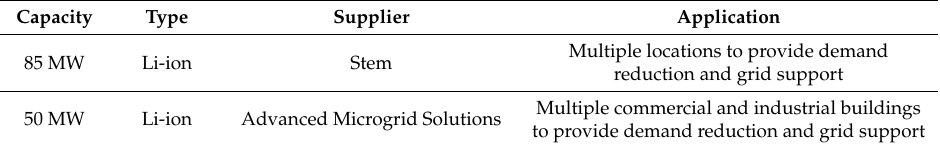
Table 5. Southern California Edison (SCE) behind the meter battery storage projects